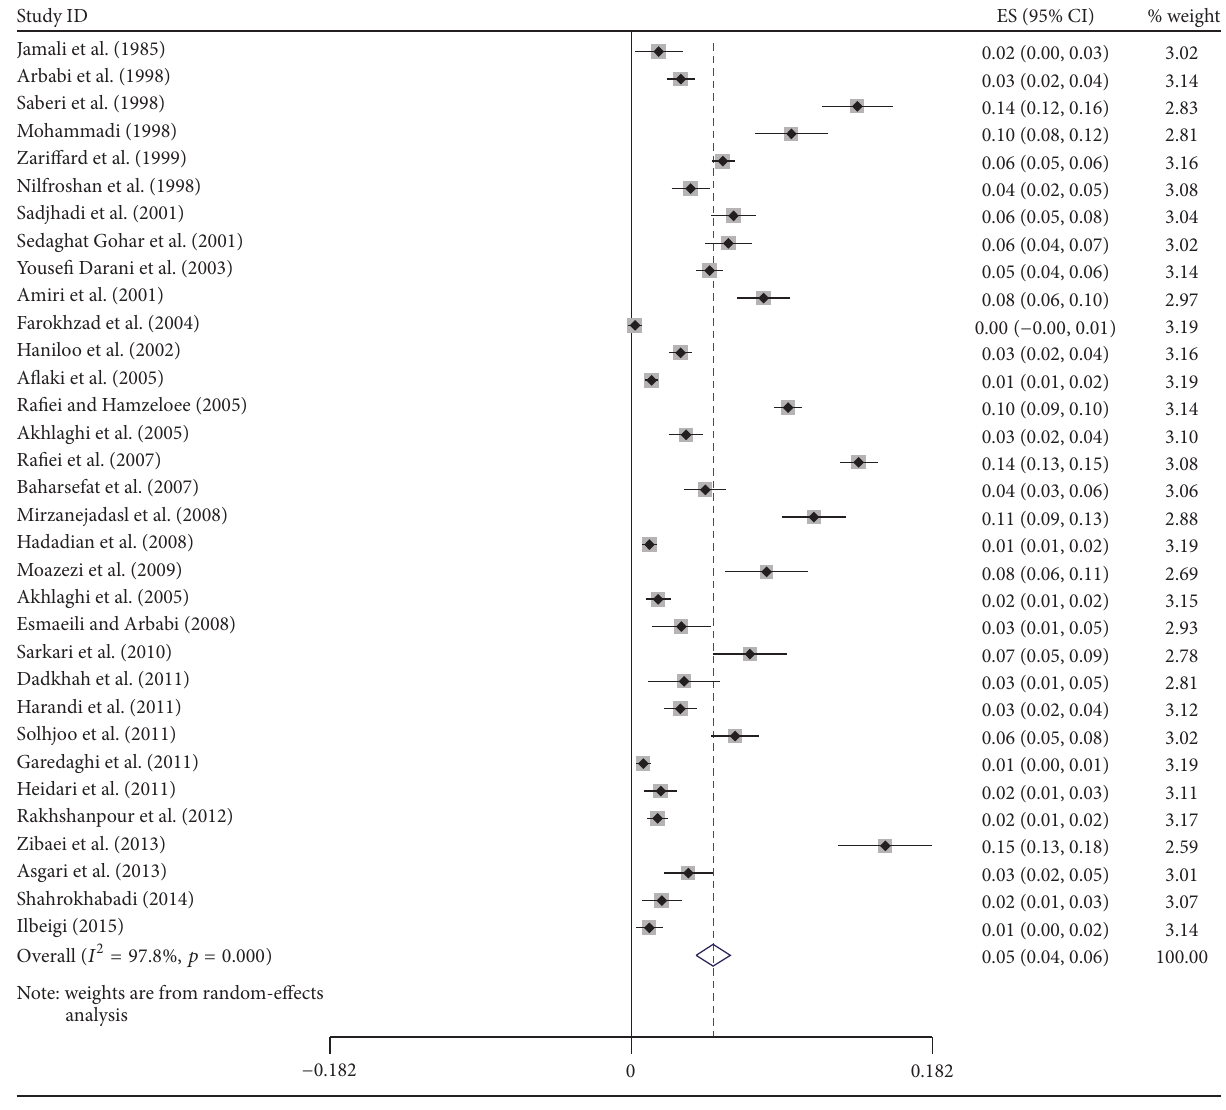
was significantly greater than other methods ( 𝑝 < 0.001